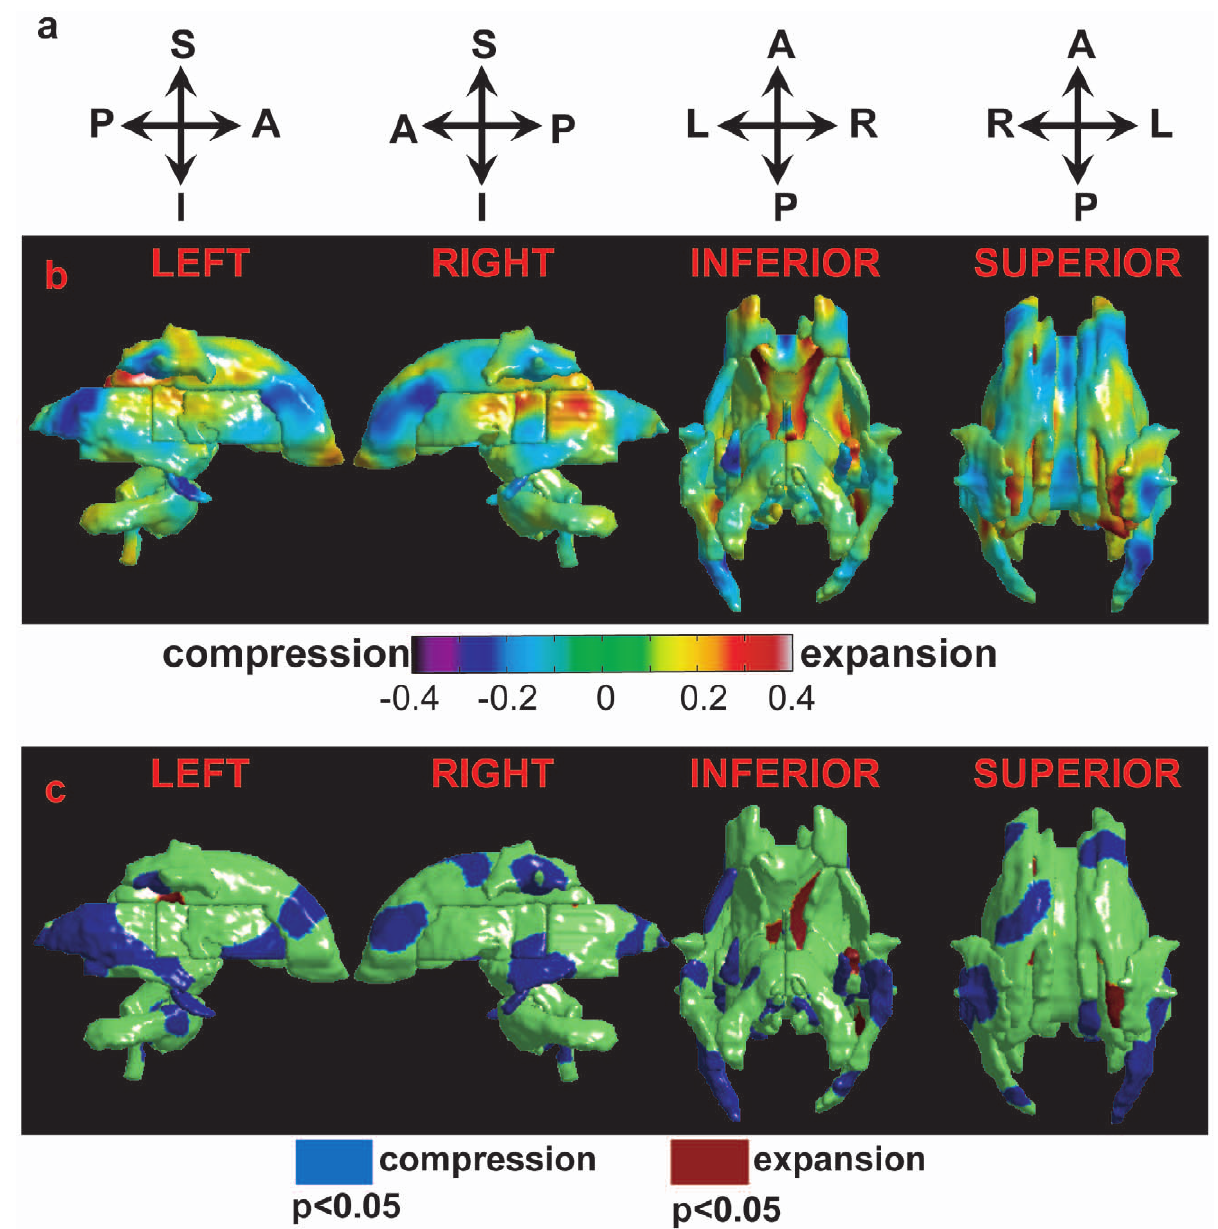
Figure 3. Deformation maps of the white matter tracts. Row (a) illustrates the anatomical orientation of the corresponding column. Row (b) shows the group difference map in the log-Jacobian determinant between the healthy control subjects and patients with AD. Warm color denotes regions with shape expansion in the AD group; while cool color represents regions with shape compression. Row (c) illustrates shape abnormalities of the deep white matter tracts in the patients with AD relative to the healthy control subjects. Blue denotes the regions with significant surface compression in the AD group compared with the control group, while red colors the regions with significant surface expansion in the AD group relative to the control group. Left, right, inferior, and superior views are respectively illustrated from the left to the